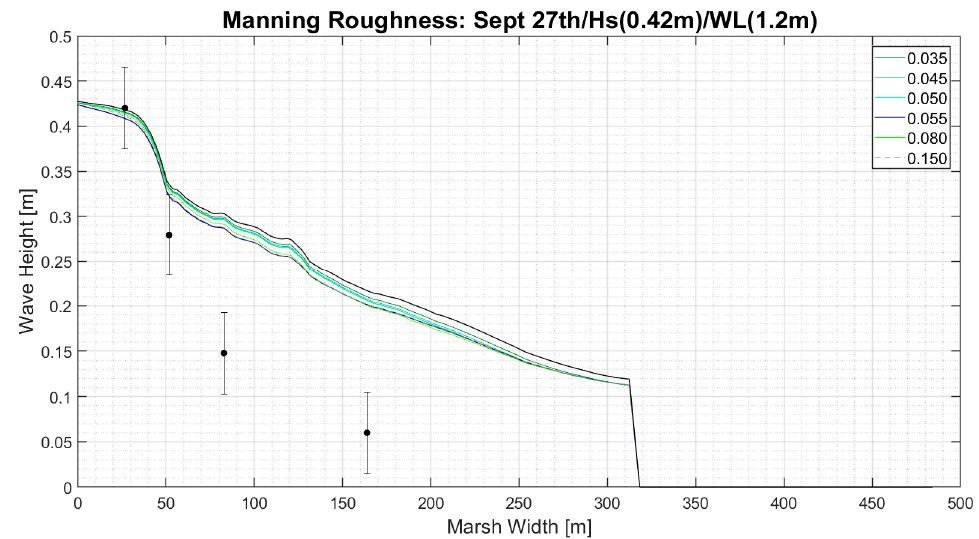
Figure 10. Wave dissipation profiles for varied Manning roughness coefficients (implicit representation). The magnitudes of the Manning roughness coefficients are color coded, with their results indicated.